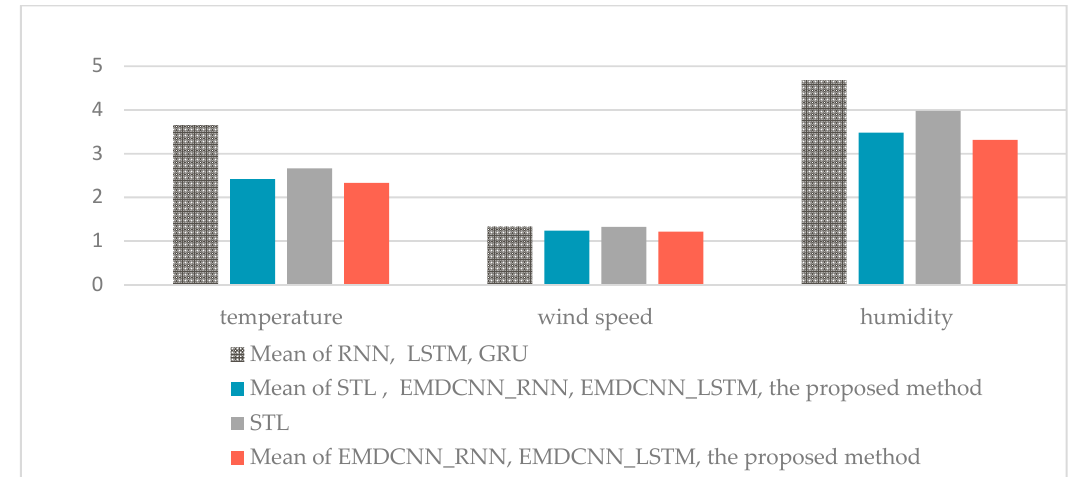
Figure 9. The histogram of different RMSE values.